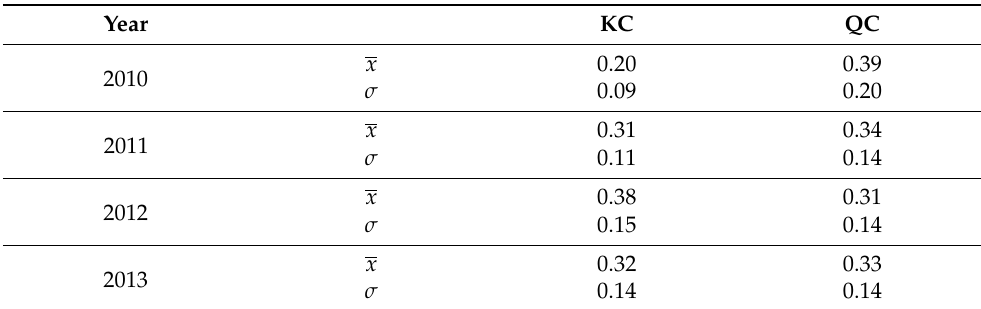
Figure 4. Spatial distribution of mean annual MODIS AOD values from 2010 to 2020 in the Philippines. Note that “ (cid:73) ” corresponds to Quezon City and “ ” corresponds to Koronadal City. (cid:35) Table 2. Statistics of monthly MODIS AOD values at the two study areas from 2010 to 2020. Note that “ − “ signifies unavailability of